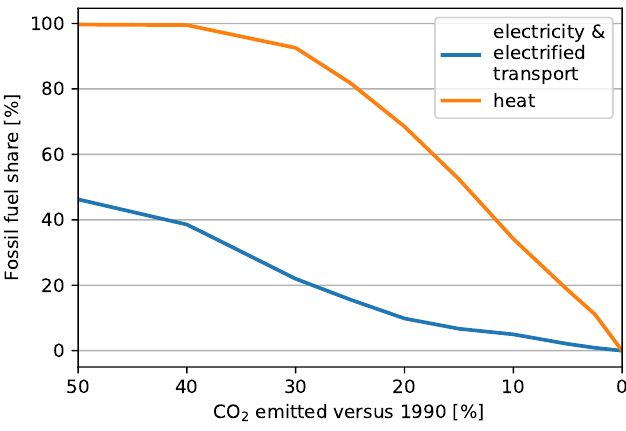
Figure 5. Share of fossil fuel energy provision in electricity, electrified transport, and heat.